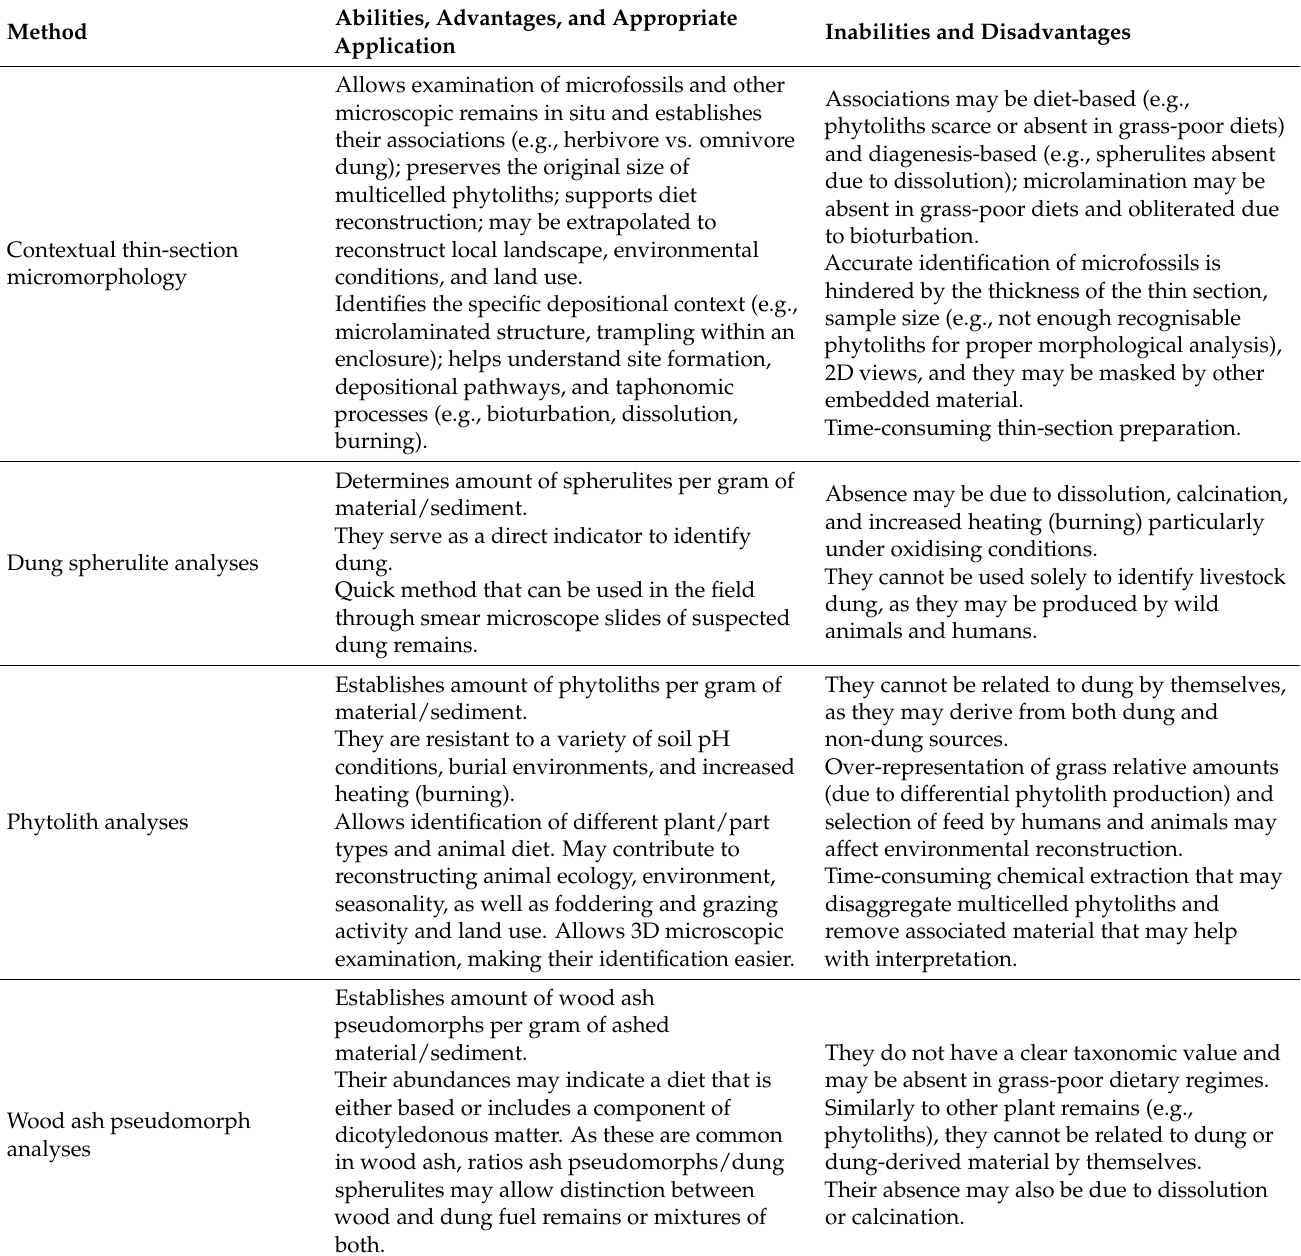
Table 1. Summary of the main methods and analytical techniques used in the geo-ethnoarchaeological case studies to investigate modern livestock dung (based on [3,18,29] and personal